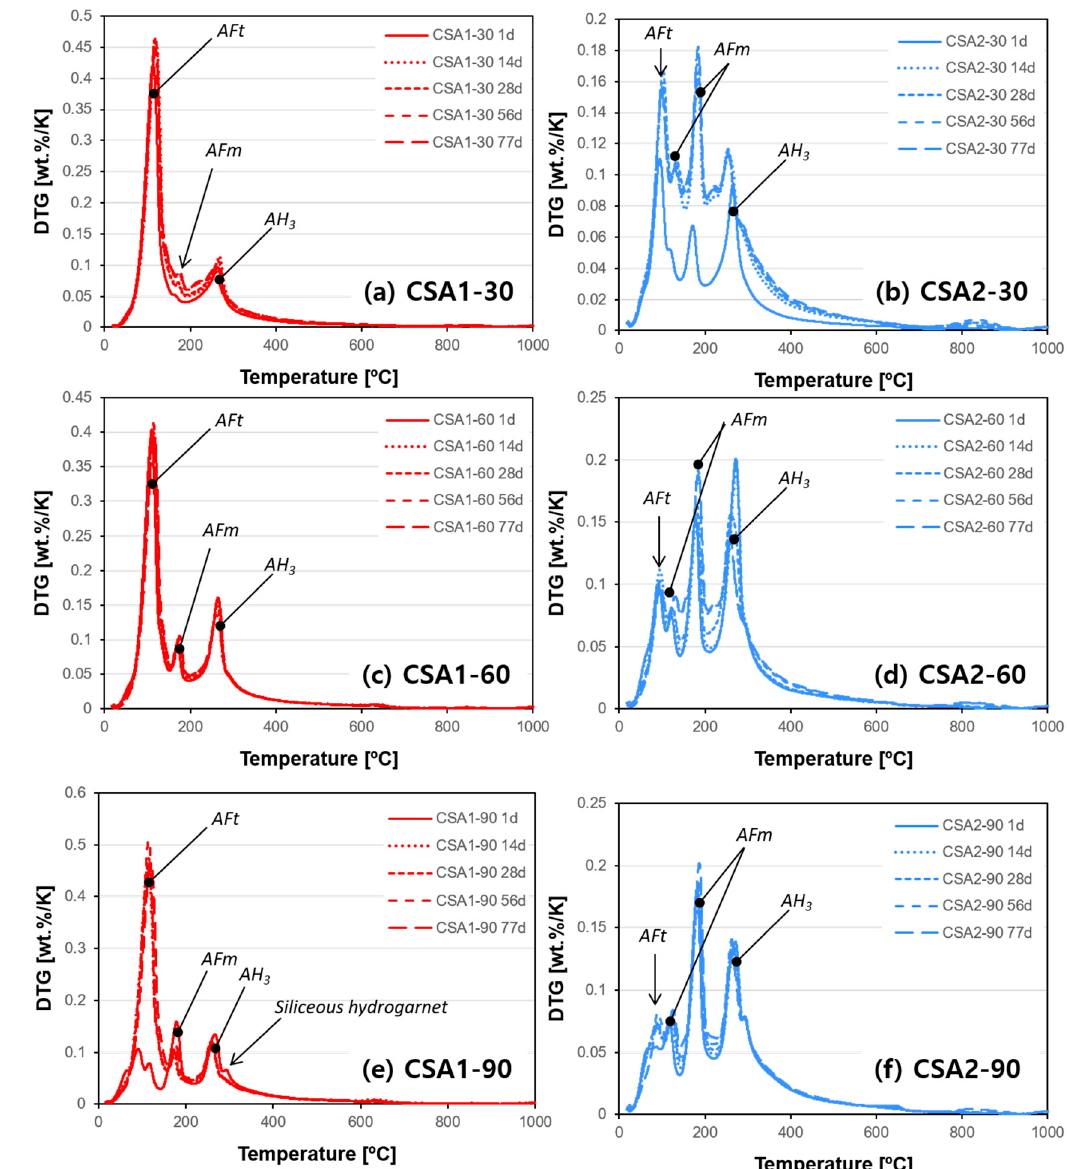
Figure 10 . Derivative weight loss curves from TGA of each samples cured at ( a , b ) 30 °C, ( c , d ) 60 °C, Figure 10. Derivative weight loss curves from TGA of each samples cured at ( a , b ) 30 ◦ C, ( c , d ) 60 ◦ C, and ( e , f ) 90 °C. and ( e , f ) 90 ◦